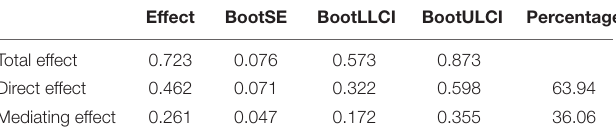
TABLE 3 | Total effect, direct effect, and mediating effect.